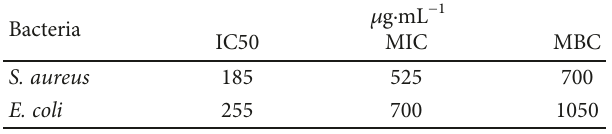
Table 1: IC50, MIC, and MBC of CGCe.